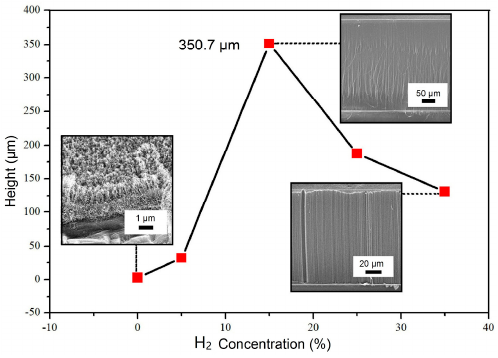
Figure 2. Heights of VACNTs synthesized under various hydrogen concentrations.